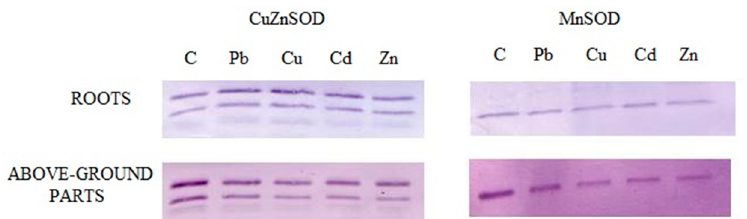
Figure 7. E ff ects of 50 µ M Pb, Cu, Cd, and Zn for 24 h on the CuZnSOD and MnSOD of roots and above-ground parts of B. juncea var. Malopolska seedlings. The protein content was evaluated by Western blot using specific